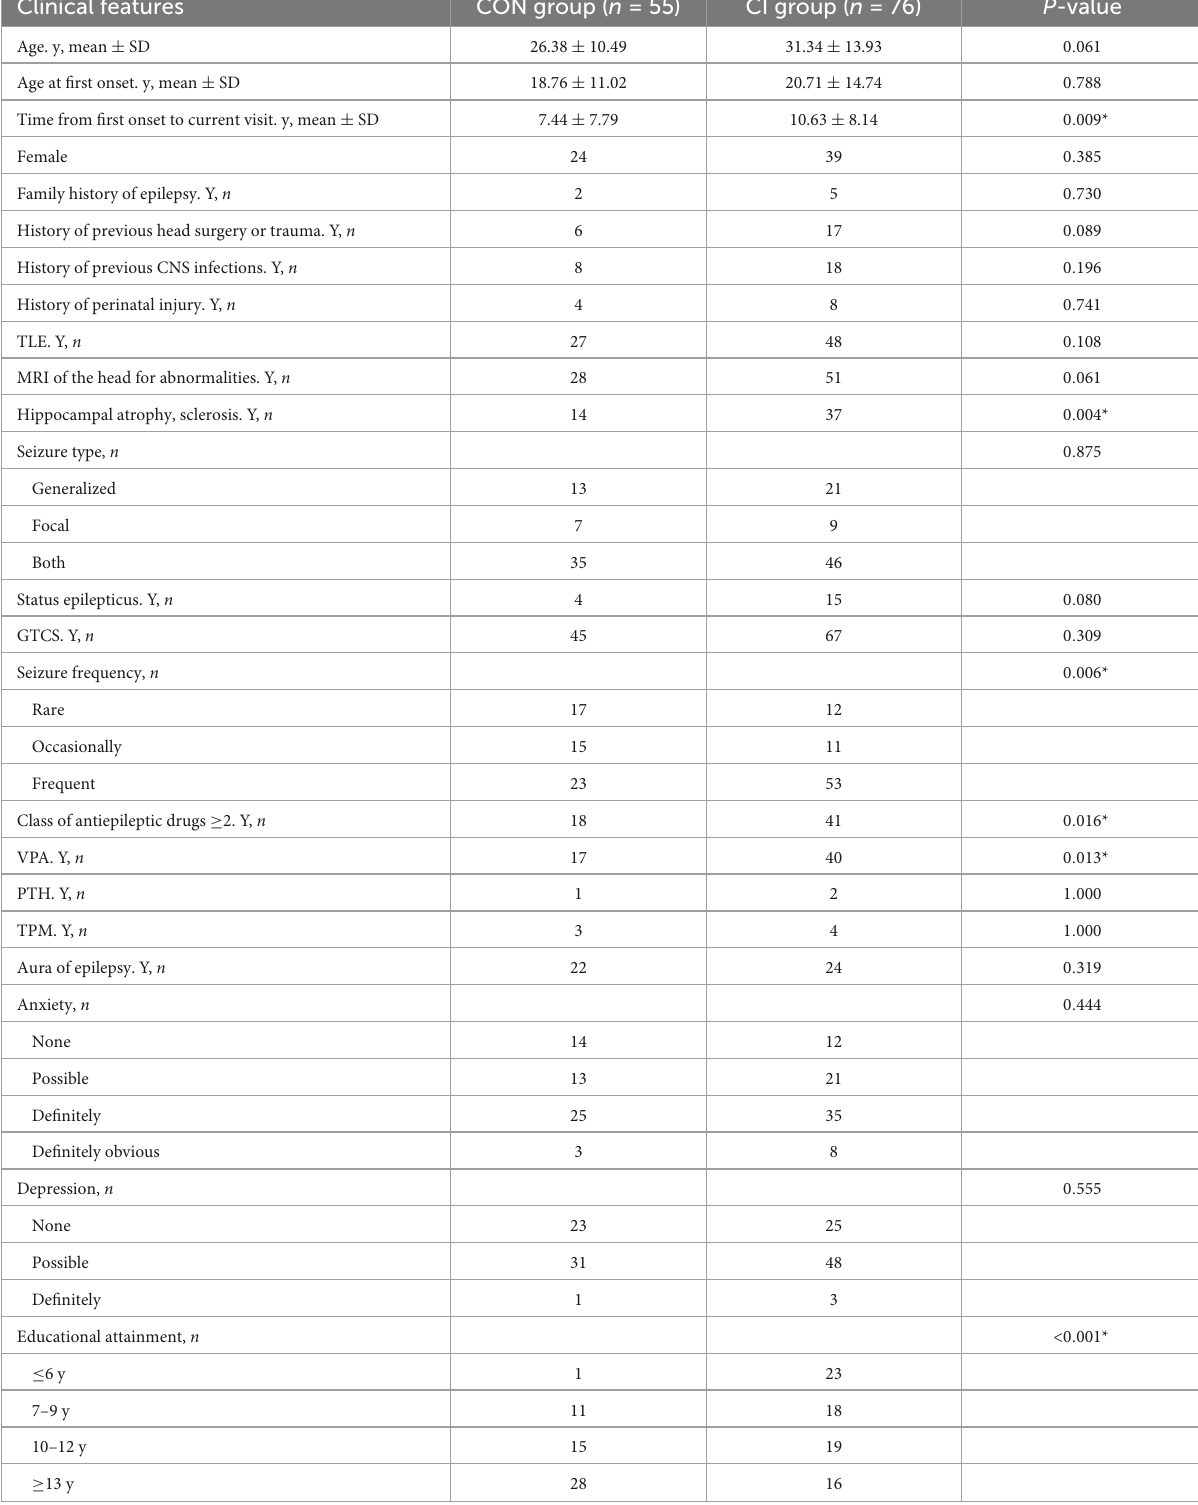
TABLE 2 Demographic information and clinical